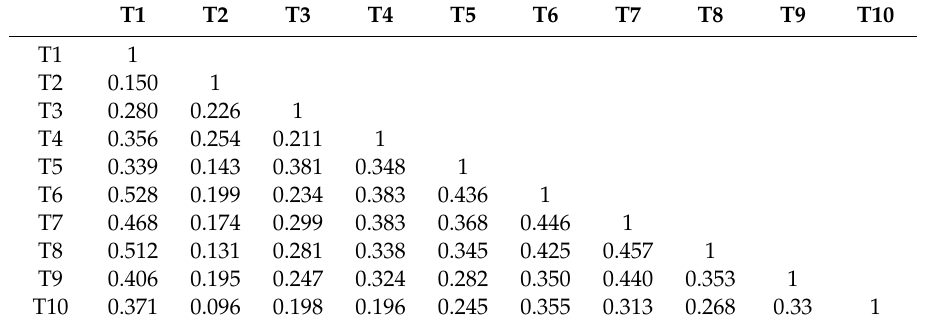
Table 6. The similarity between each pair of nodes in the technology layer.